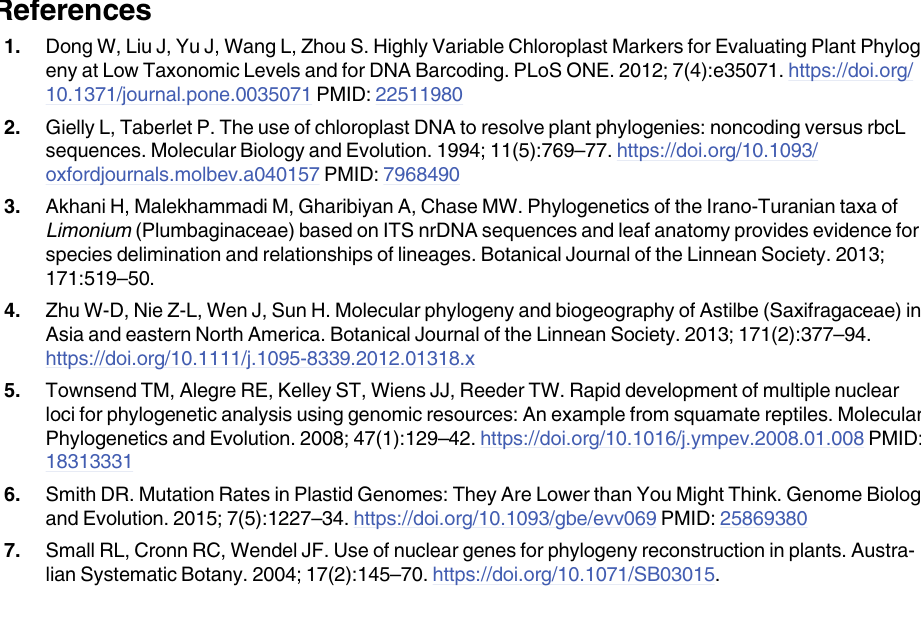
S1 Protocol. Detailed target capture